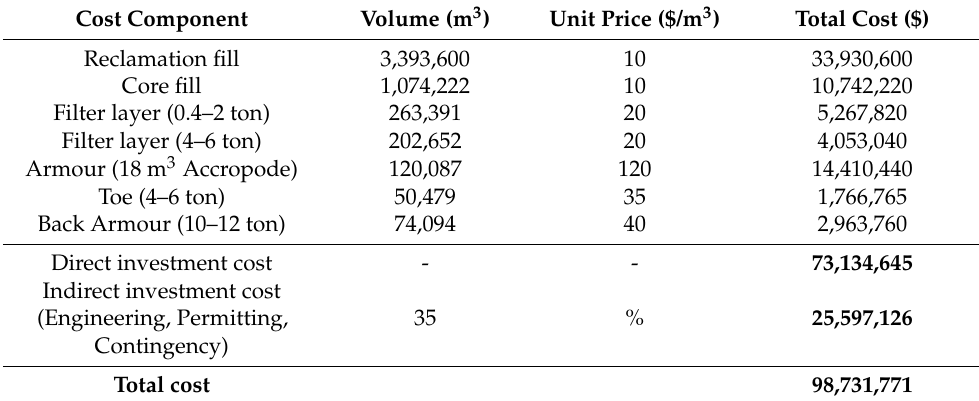
Table A1. Cost estimate for land reclamation: Alternative No. 1.